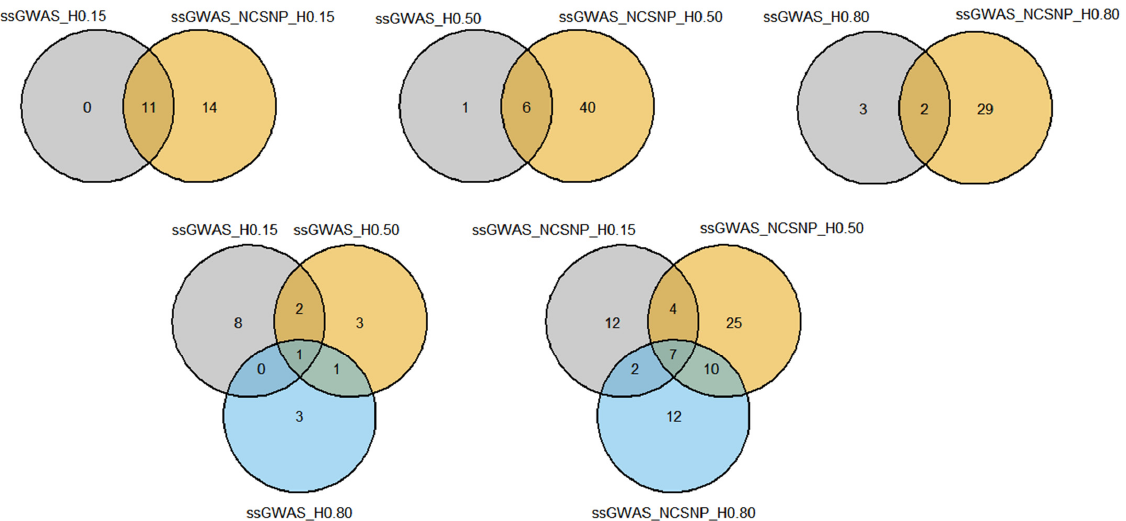
Figure 9. Venn diagrams showing the number of genes overlapping among different single-step genome-wide association studies (ssGWAS) with haplotypes and non-clustered SNPs. ssGWAS_H0.15, ssGWAS_H0.50, and ssGWAS_H0.80: ssGWAS using only haplotypes from blocks with linkage disequilibrium (LD) thresholds of 0.15, 0.50, and 0.80, respec- tively; ssGWAS_NCSNP_H0.15, ssGWAS_NCSNP_H0.50, and ssGWAS_NCSNP_H0.80: ssGWAS using non-clustered SNPs and haplotypes from blocks with LD threshold of 0.15, 0.50, and 0.80, respectively.